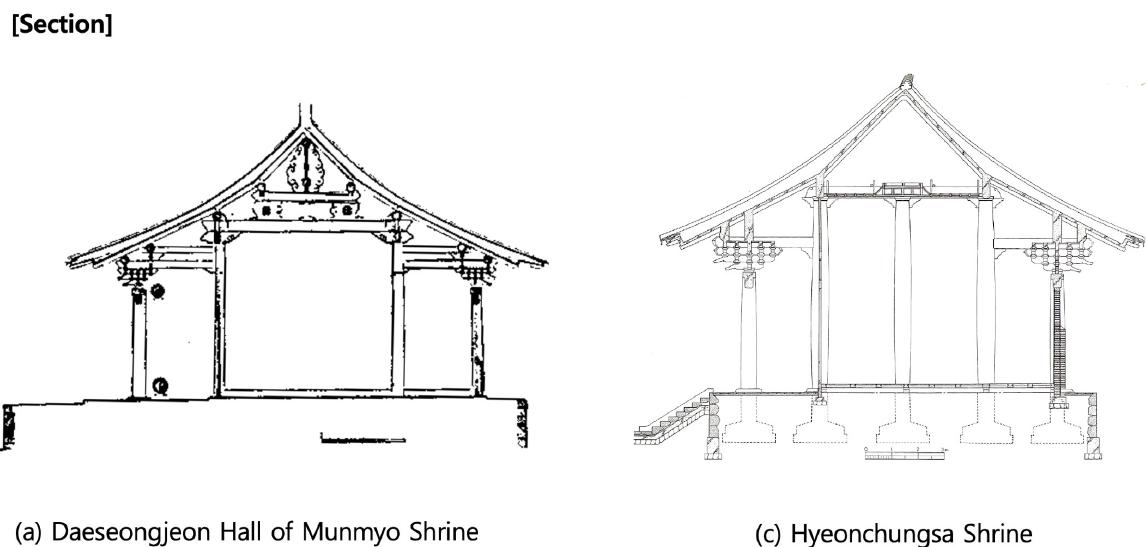
Figure 15. Comparison between Section of the Hyeonchungsa Shrine and Daeseongjeon Hall of Munmyo shrine (not drawn in scale) (Source: Bong-jin Kang, Cultural Heritage Administration).